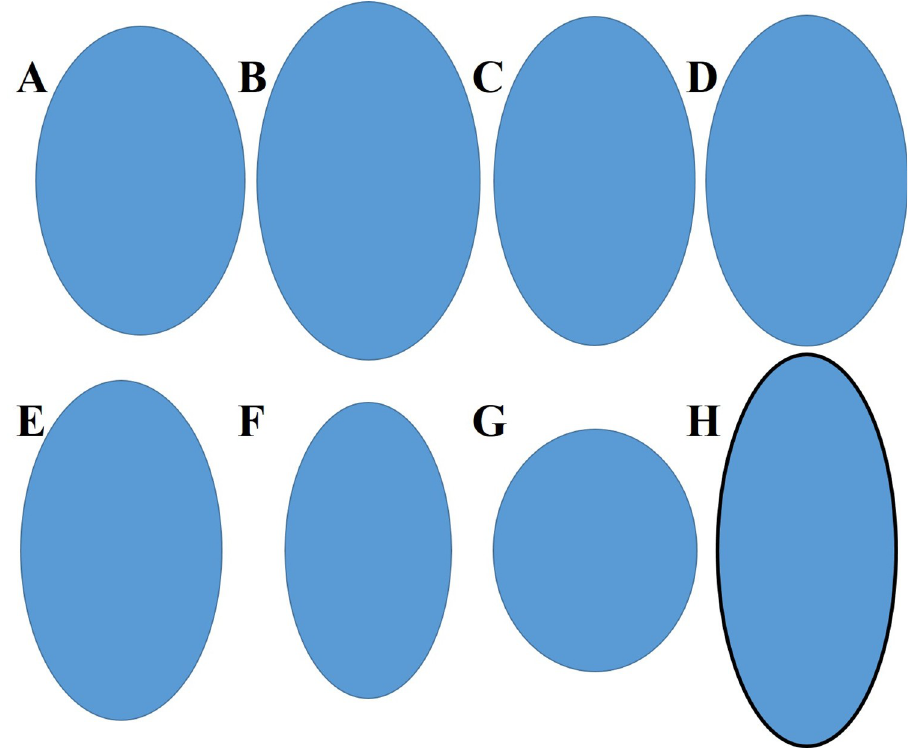
Fig 3. Egg shapes and eggshells of freshwater turtles found in South Korea. (A) Pseudemys peninsularis ; (B) P . concinna ; (C) Trachemys scripta ; (D) Graptemys ouachitensis ; (E) G . geographica ; (F) Chrysemys picta ; (G) Chelydra serpentina ; (H) Mauremys reevesii . The eggs without outlines indicate parchment shells and the egg with a black outline indicates a brittle